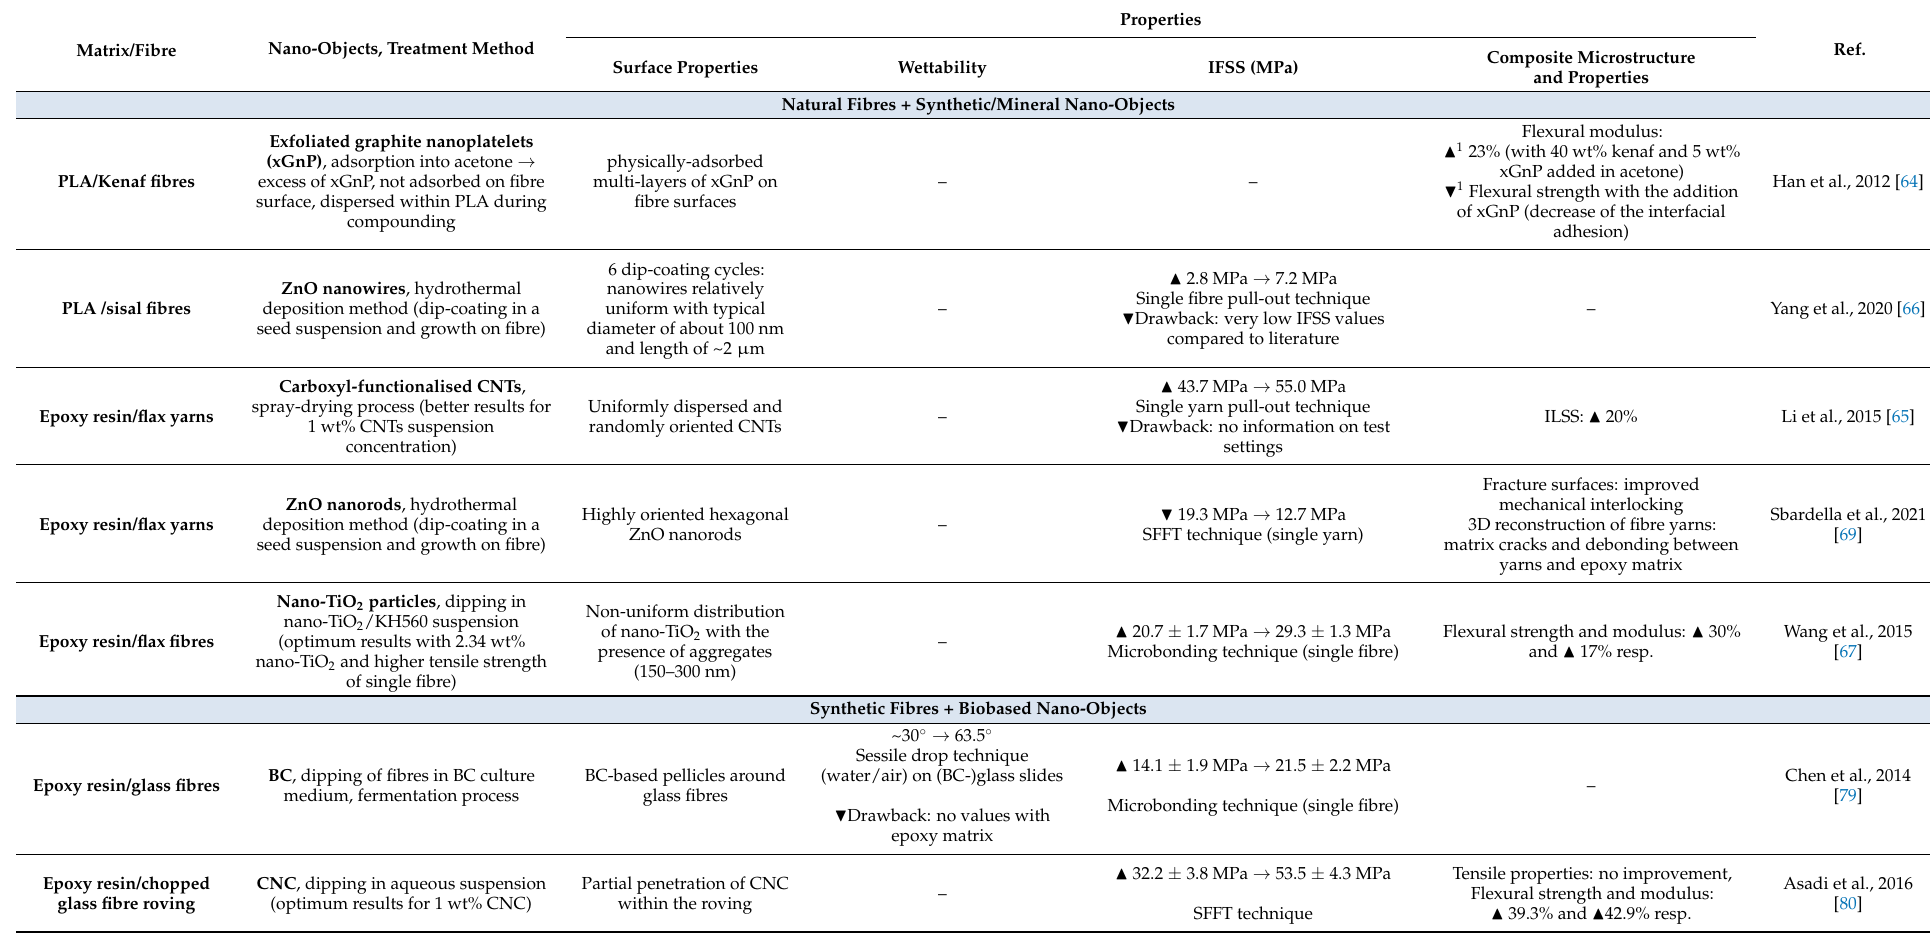
Table 2. Hybrid hierarchical composites: characteristics and